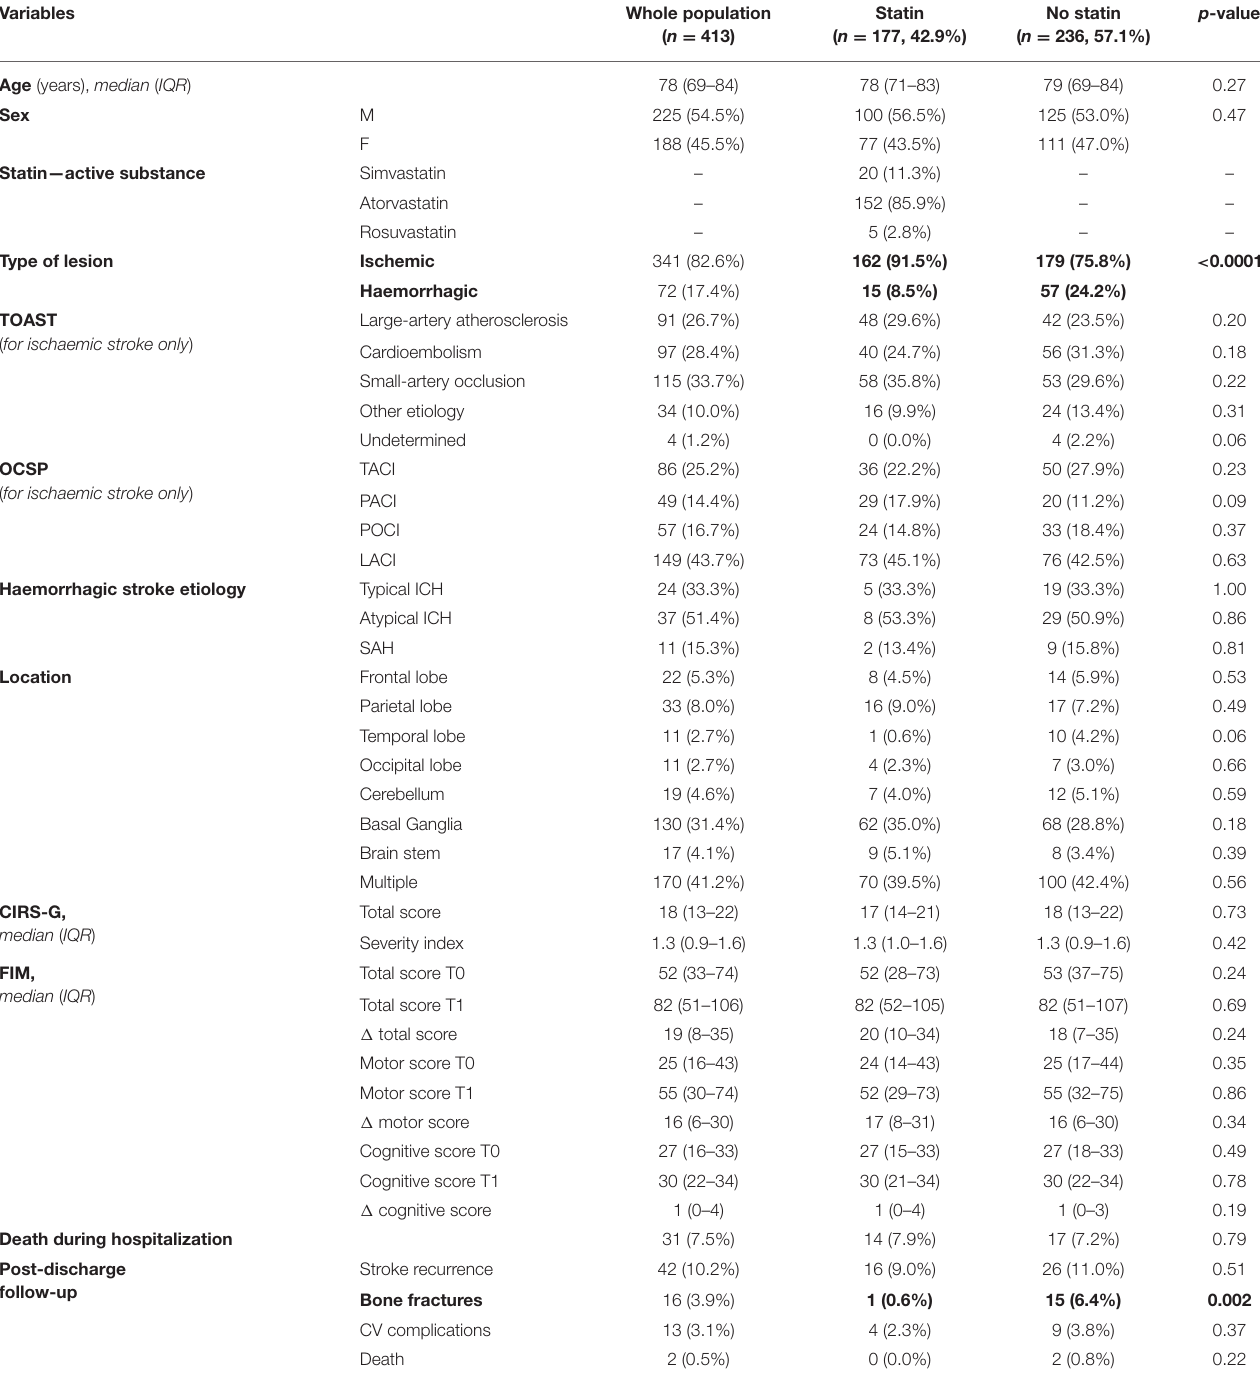
TABLE 1 | Clinical, rehabilitation, and follow-up characteristics of the population as a whole and subdivided into two groups according to the use or not of statin therapy.